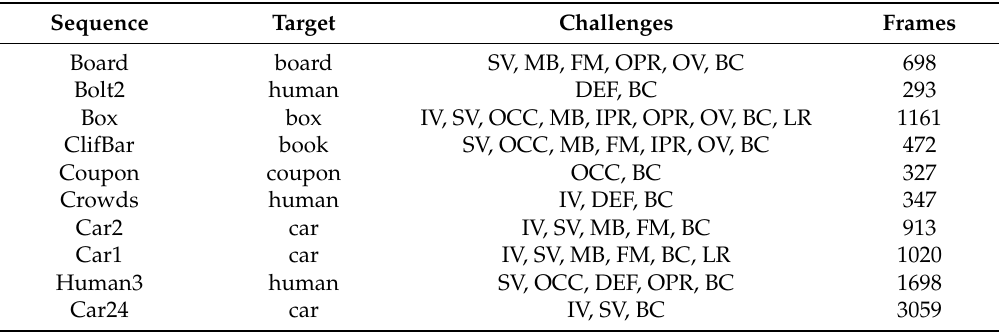
Table 1. An overview of another 10